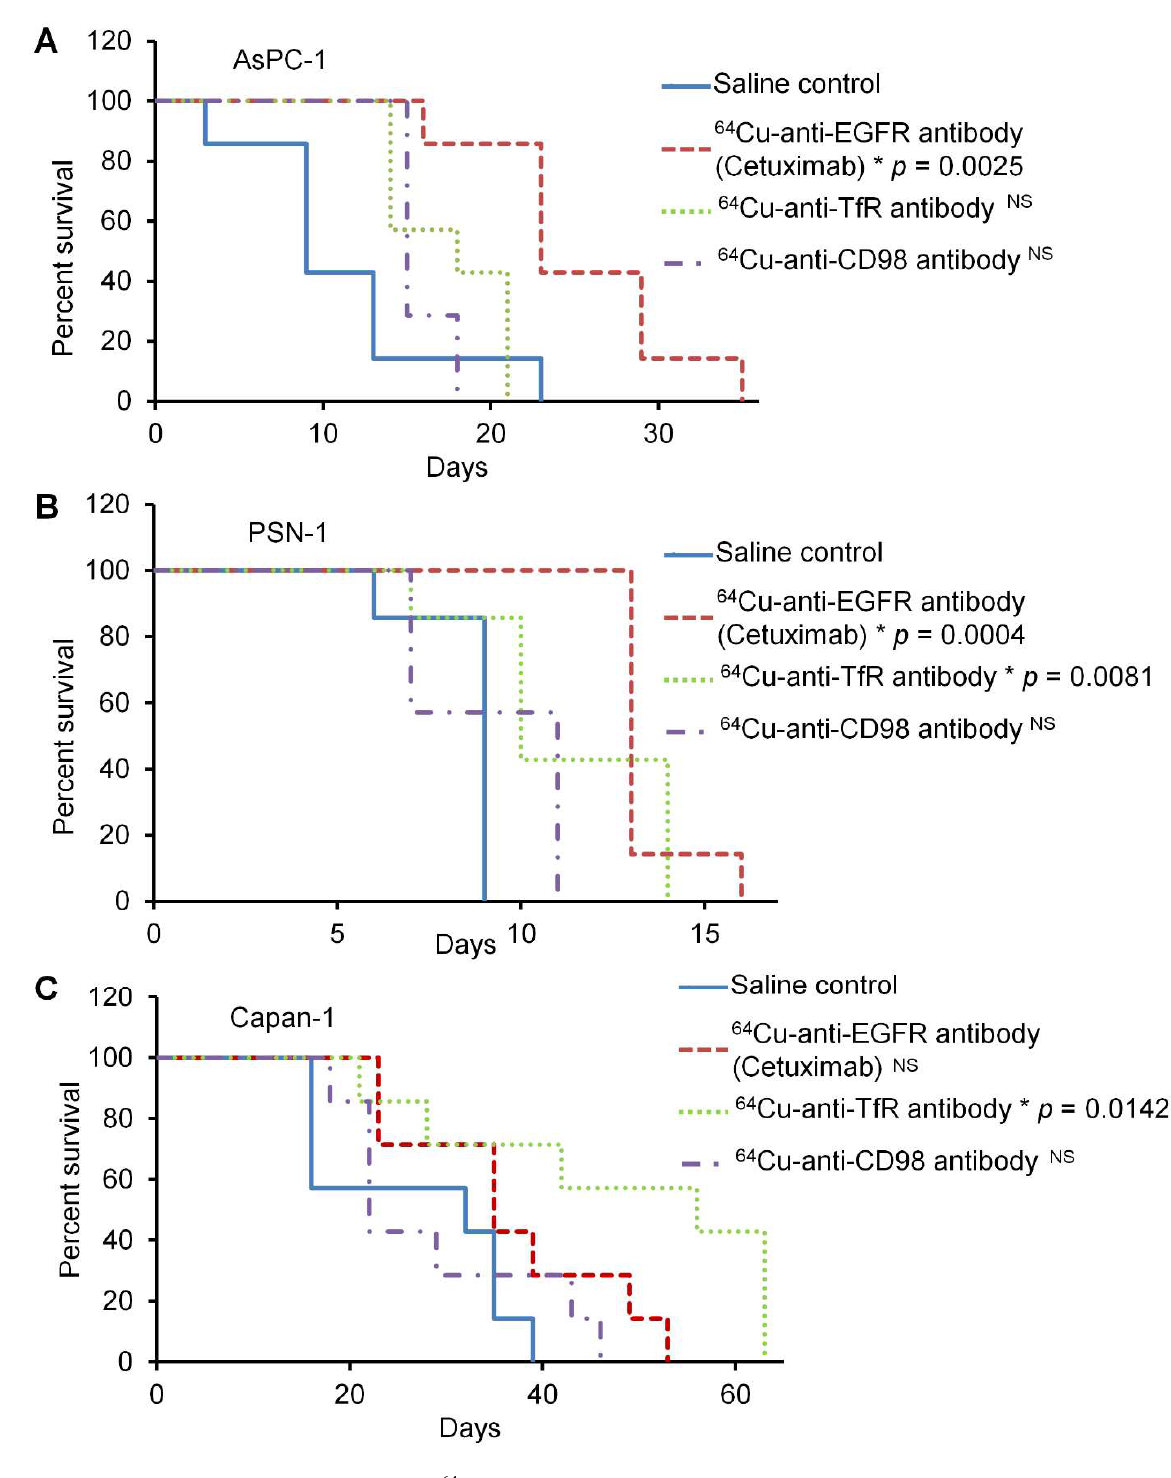
Figure 4. In vivo 64 Cu-i p RIT study using the peritoneal dissemination models of AsPC-1, PSN-1, and Capan-1. Survival curves of the saline control (blue line), 64 Cu-anti-EGFR antibody (cetuximab) (red line), 64 Cu-anti-TfR antibody (green line), and 64 Cu-anti-CD98 antibody (purple line) for AsPC-1 ( A ), PSN-1 ( B ), and Capan-1 ( C ), respectively ( n = 7/group). Asterisks indicate significant differences ( p < 0.05). NS = not significant.